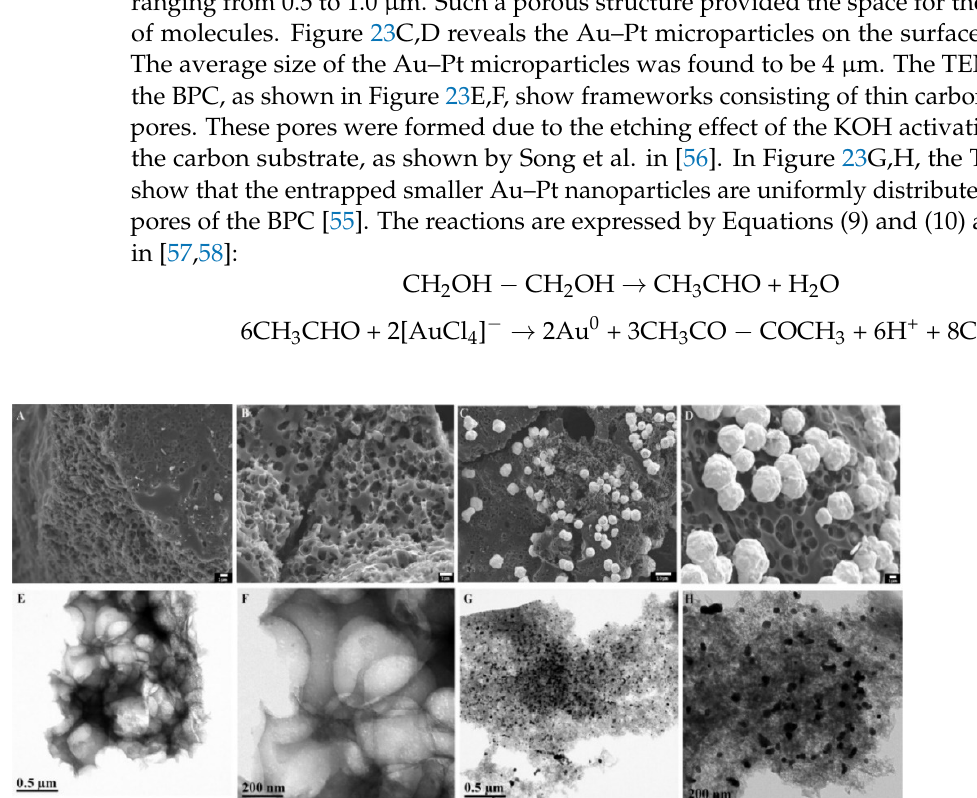
Figure 23. SEM images of BPC ( A , B ) and Au–Pt@BPC ( C , D ), TEM images of BPC ( E , F ) and Au–